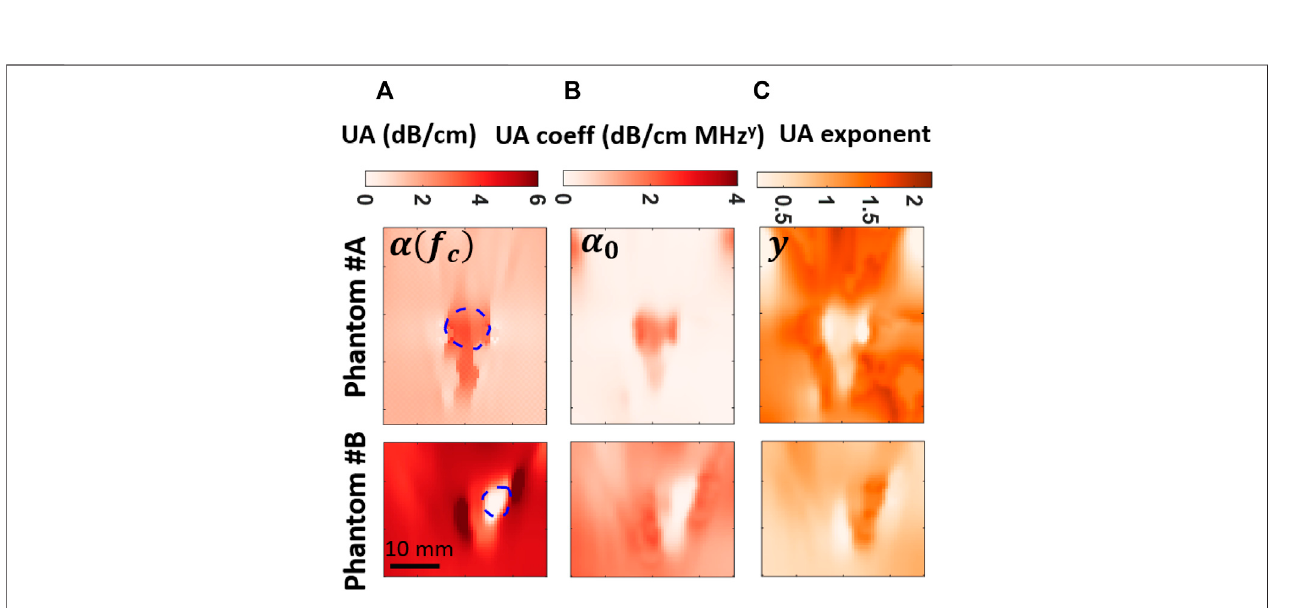
FIGURE 8 | Comparison of frequency-dependent UA imaging for phantom and ex-vivo tissues, with columns from left to right (A-D) : α at the center frequency 5.2 MHz; reconstructed α 0 maps; reconstructed y